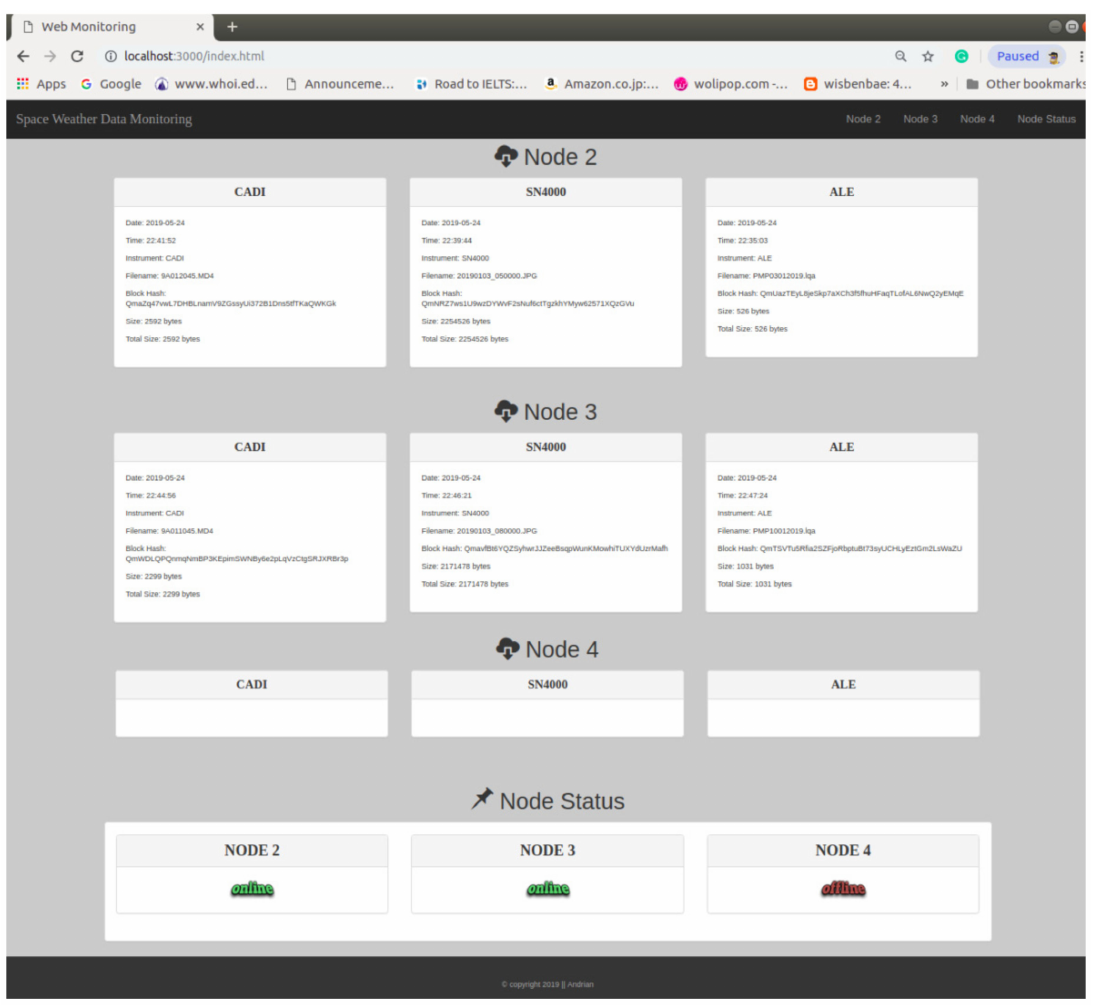
Figure 10. Index page for web